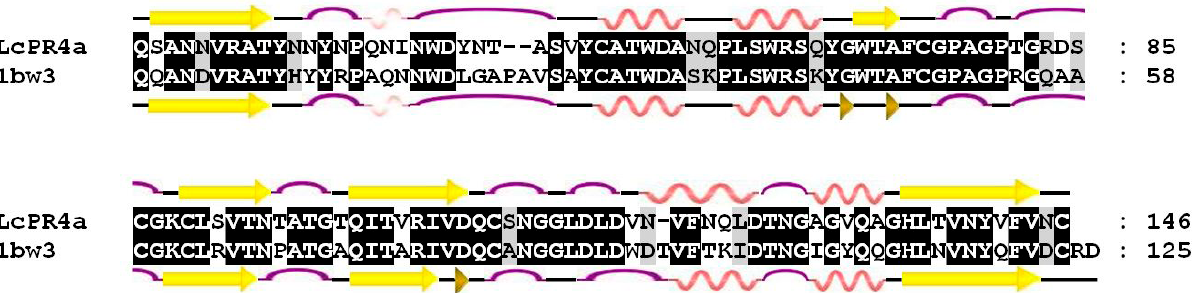
Figure 3. Structure-based sequence alignment of Barwin protein (PDB 1bw3) and predicted amino acid sequence of LcPR4a after cleavage of the putative signal peptide, depicting the secondary structure elements corresponding to helices ( ), beta strands ( ), isolated beta bridges ( ), turns ( ) and coils ( – ) assigned by STRIDE (Heinig et al. ,